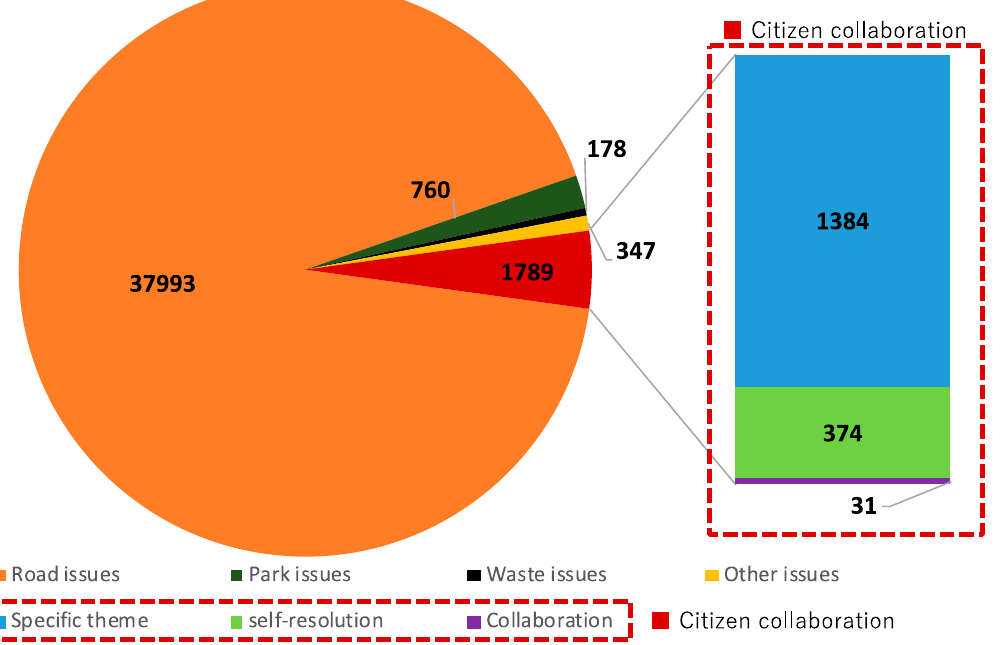
Figure 6. The reporting types of the Chiba-repo platform (N = 41,067 reports).